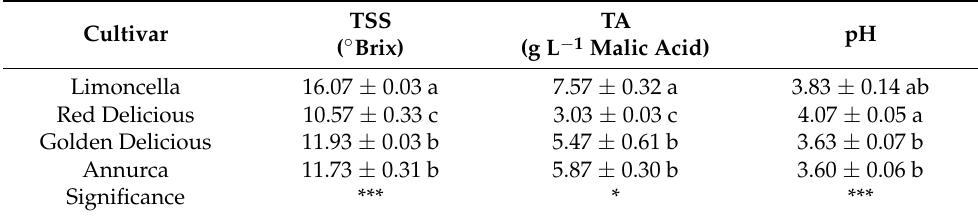
Table 1. Fruit characteristics: total soluble solids (SSC), titratable acidity (TA) and pH. Means followed by different letters are significantly different for p ≤ 0.05. *, *** significant at p ≤ 0.05 and 0.001,